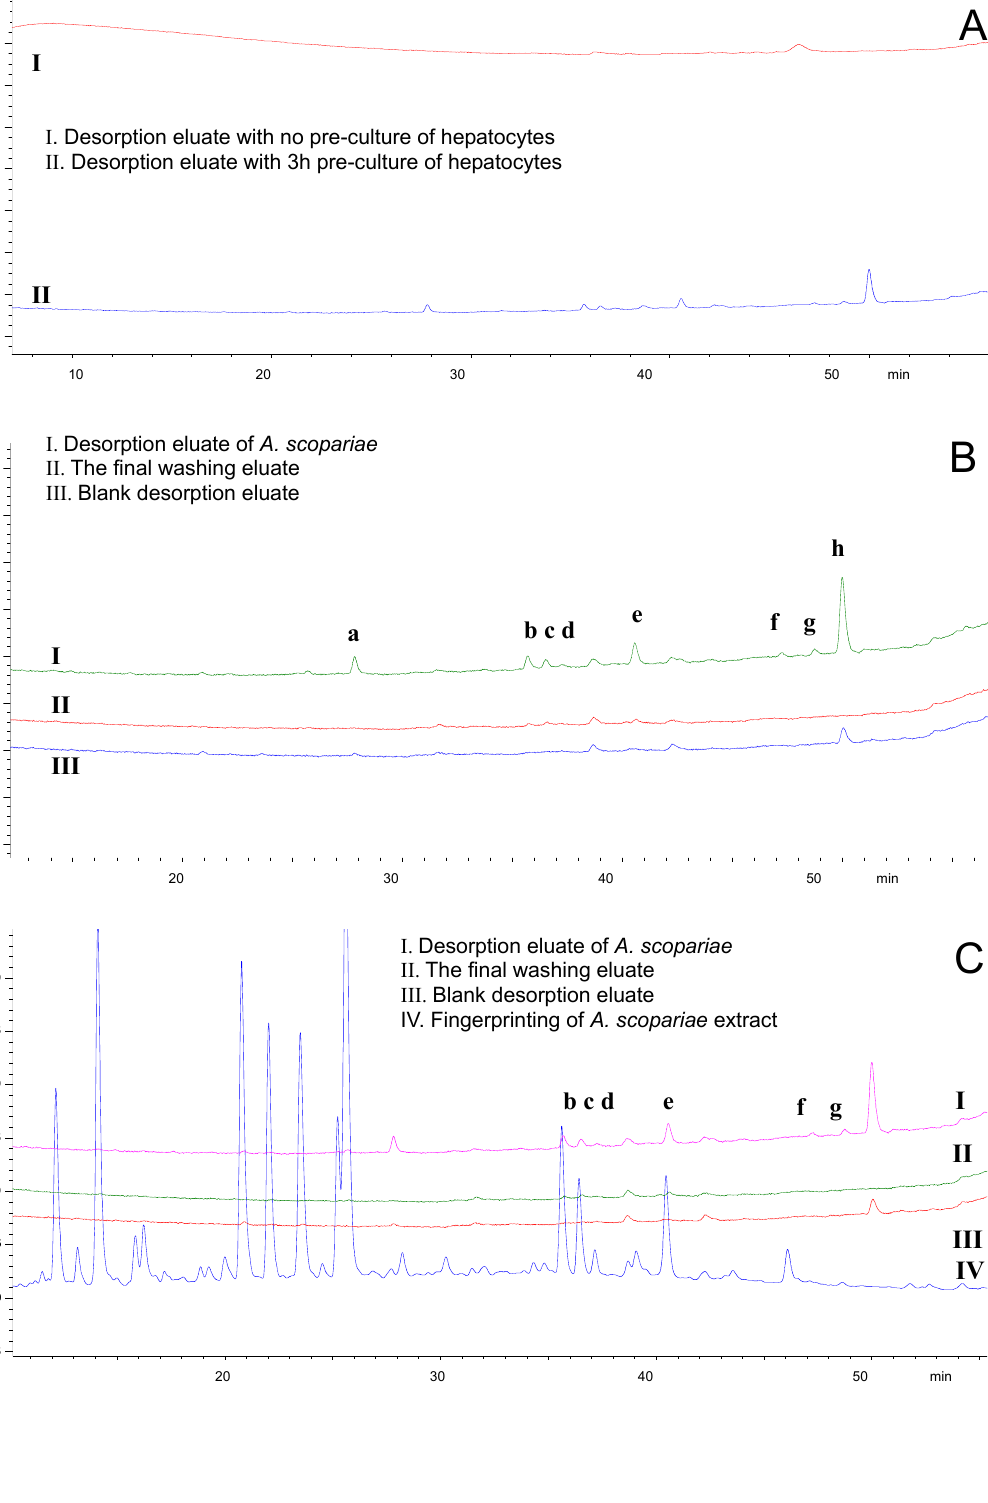
Figure 3. Detection of the components in A. scopariae after extraction by hepatocytes. ( A ) Effect of pre-culture of hepatocytes. No detectable components were found in the desorption eluate if the cells were not precultured, while some peaks appeared if the cells were pre-cultured for 3 h. ( B ) Compared with the blank desorption and the final washing eluate, there were 7 peaks detected in the desorption eluate after treatment with A. scopariae . These peaks are marked “a” to “h”, respectively. ( C ) Components “b” to “g” were found in the fingerprint of A. scopariae